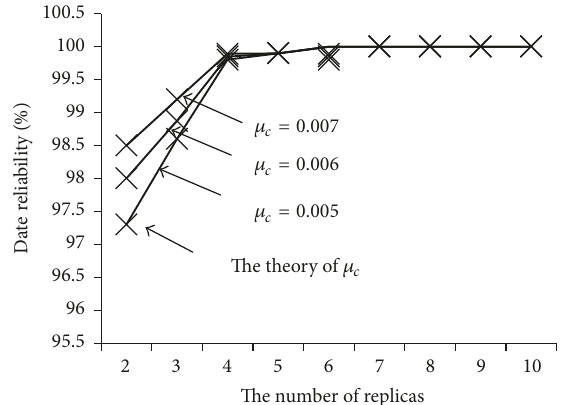
Figure 2: Data availability with number 𝐼 of